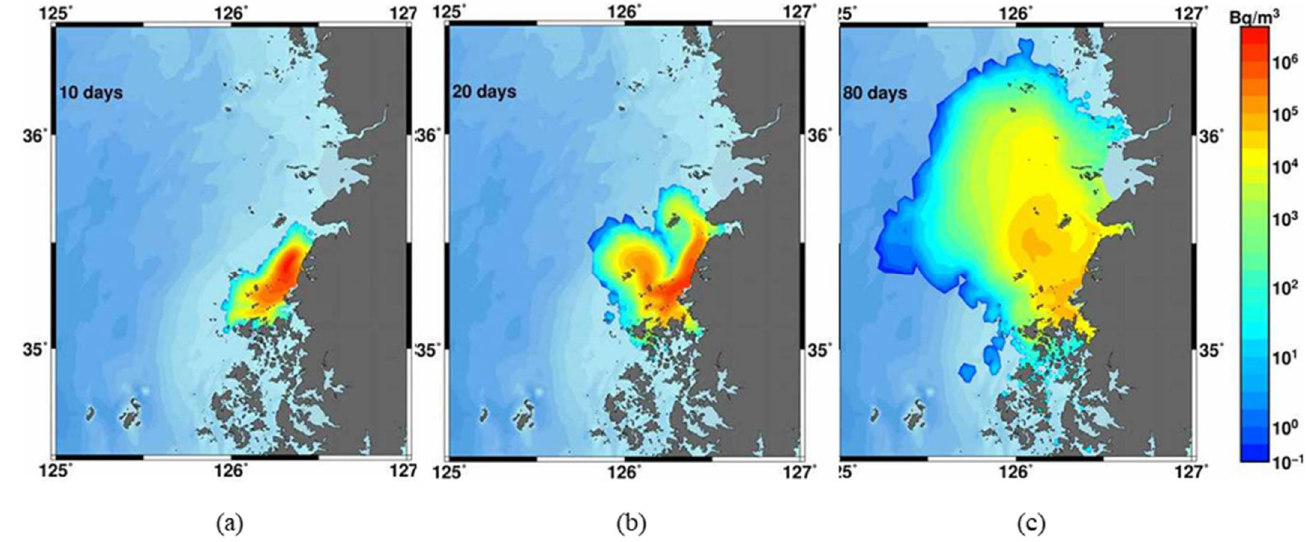
Figure 13. The surface concentration of 137 Cs after 10 days ( a ), 20 days ( b ), and 80 days ( c ) release from the Hanbit NPP.